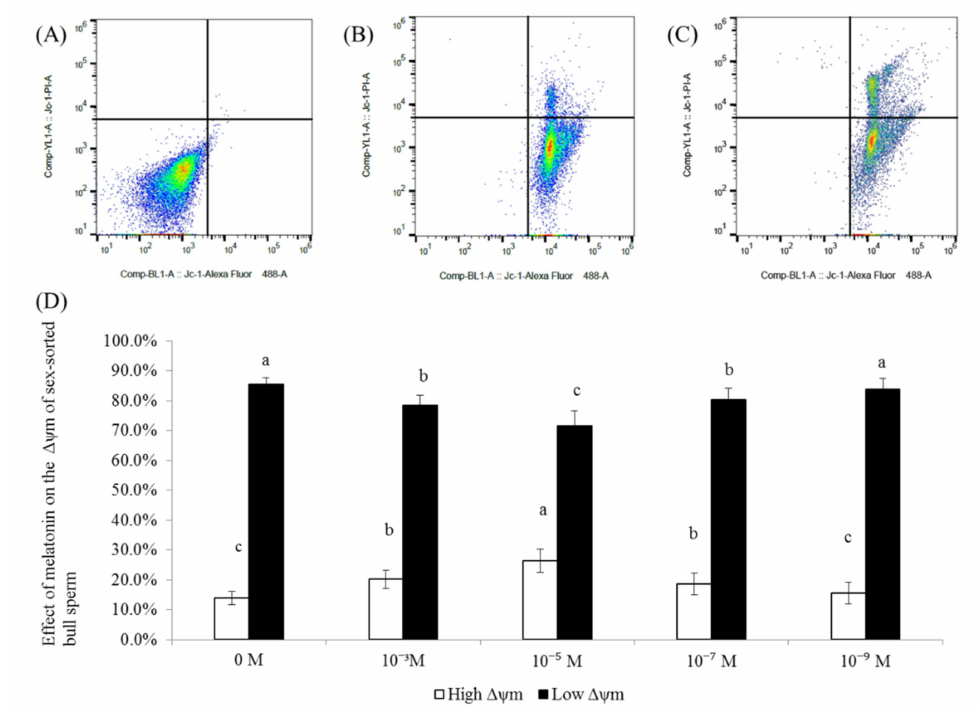
Figure 3. E ff ect of melatonin on the level of ∆ ψ m of sex-sorted bull sperm ( A ) Negative control. ( B ) Positive control. ( C ) Analysis of sex-sorted bull sperm. Quadrants represented low ∆ ψ m sperm (lower-right quadrant) and high ∆ ψ m sperm (upper-right quadrant). ( D ) E ff ect of melatonin on the level of ∆ ψ m of sex-sorted bull sperm. Lowercase letters represent statistical significant di ff erence ( p < 0.05).